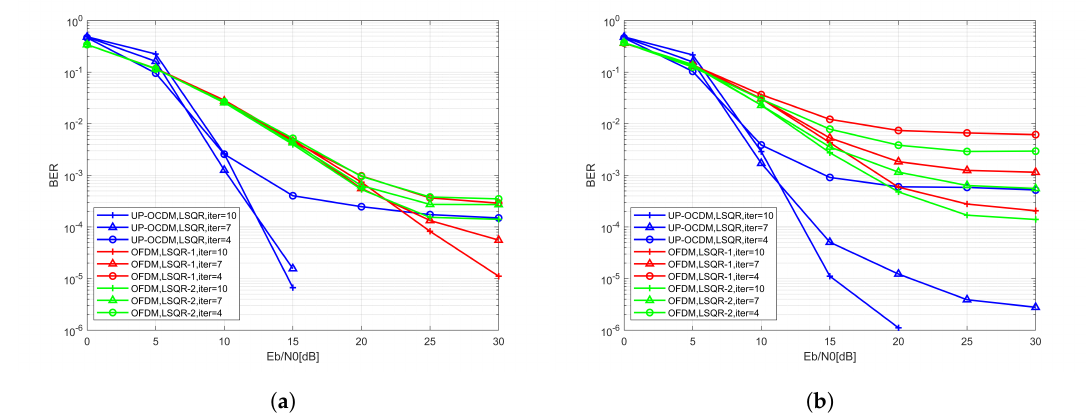
Figure 4. BER performance of the UP-OCDM and OFDM systems with iterative equalization algorithms under different iteration number i with the normalized Doppler spread of 0.1 ( a ) and 0.3 ( b